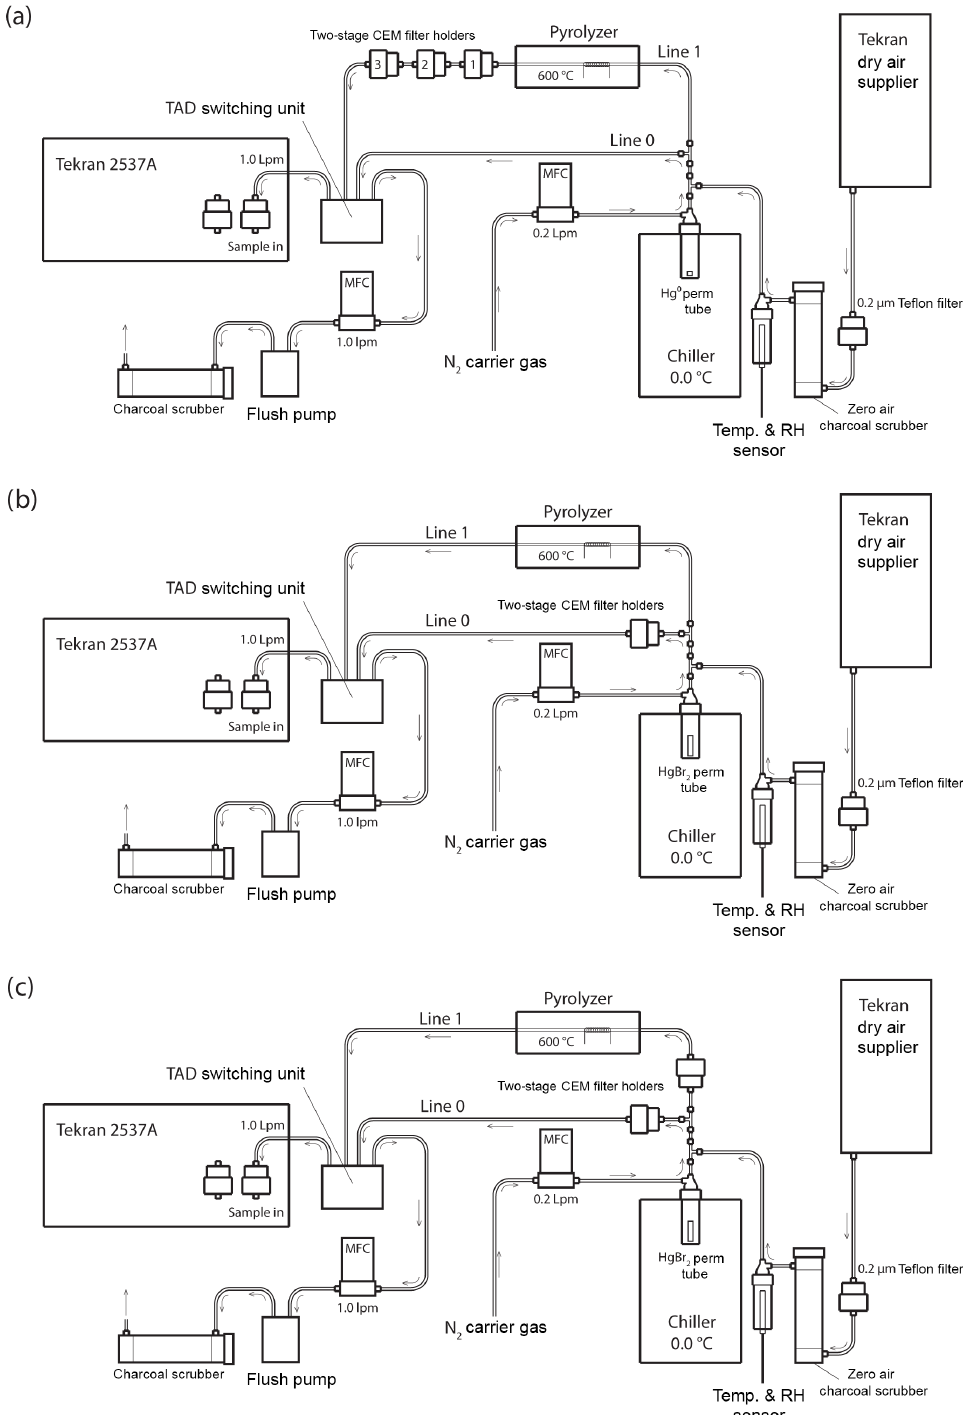
Figure 1. Schematic of the Hg vapor permeation system configurations for (a) GEM permeations, (b) HgBr 2 permeations, and (c) simultane- ous HgBr 2 loading on two sample lines. Note that the dry air supplier is disconnected for ambient and elevated humidity HgBr 2 permeations, with the sample path starting at a 0.2µm Teflon particulate filter and water bath inserted immediately in front of the charcoal scrubber. All tubing is PTFE, except for the quartz glass pyrolyzer tube and PFA filter